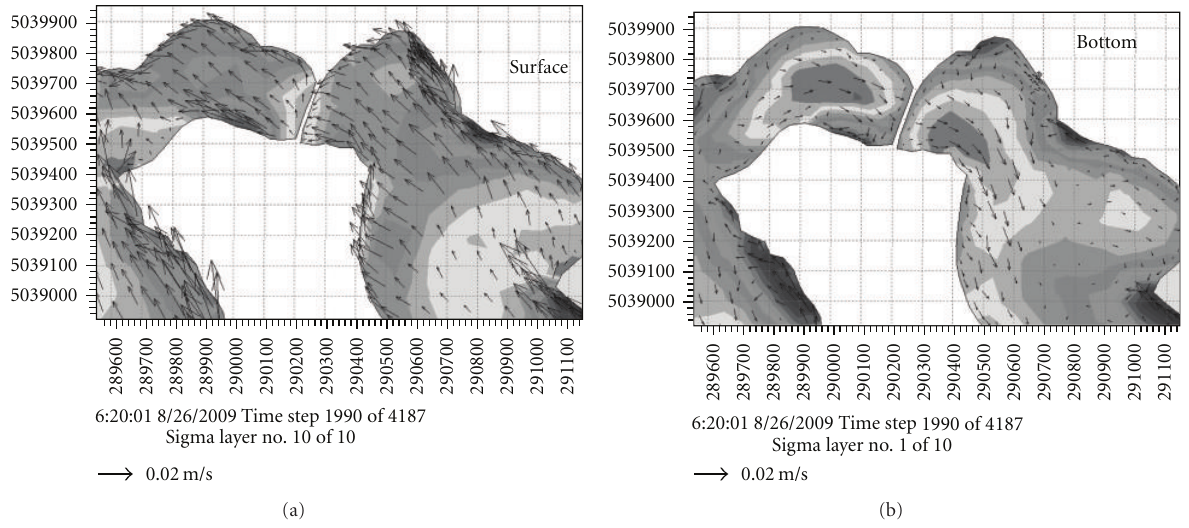
Figure 18: Simulated flow patterns in the causeway area on the Julian day 238.1 (having the strongest recorded east wind) under a closed causeway in